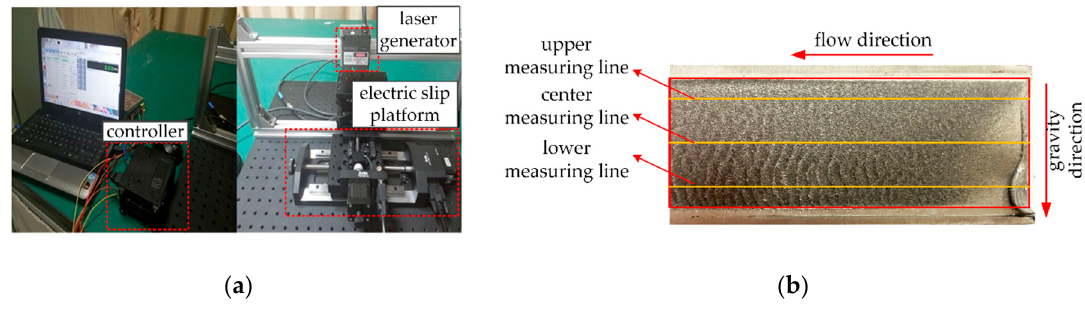
Figure 4. ( a ) Laser displacement sensor; ( b ) measurement